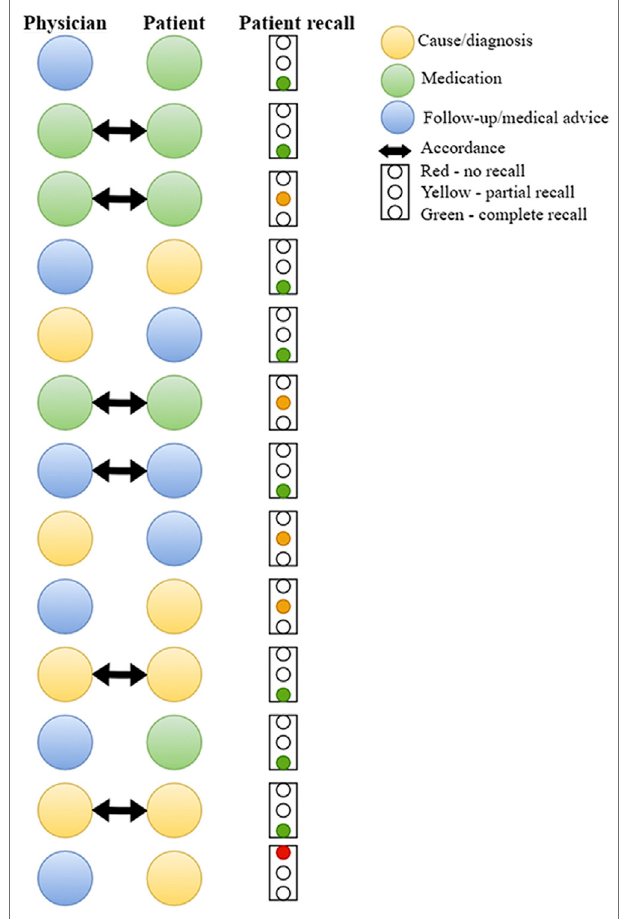
FIGURE 3 | Accordance in responses of most important information item, and concordance between patient ’ s response and patient recall of this information. Note: accordance in responses is marked with an arrow. Degree of patient recall of their response of most important